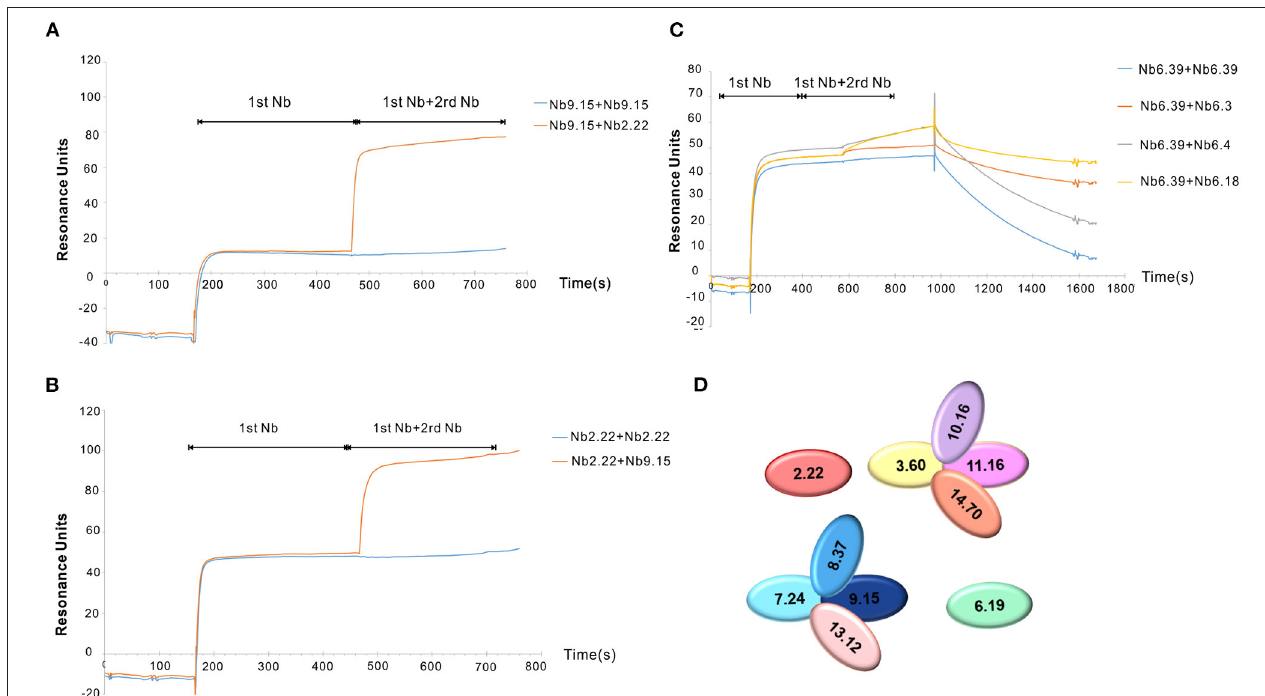
FIGURE 4 | Clec4F nanobodies epitope binning by SPR. Examples of lack of overlap between Nb2.22 (2rd Nb) and Nb9.15(1st Nb) epitopes on Clec4F antigen (A) and vice versa of Nb9.15 (2st Nb) and Nb2.22 (1st Nb) to Clec4F (B) , indicating that these bind to different epitopes. (C) The inhibitory effect of nanobodies within group 6. RU refers to resonance units. (D) Summary of Clec4F Nb epitope mappings with different colors indicating different epitope groups. The nanobodies are named according to different groups in